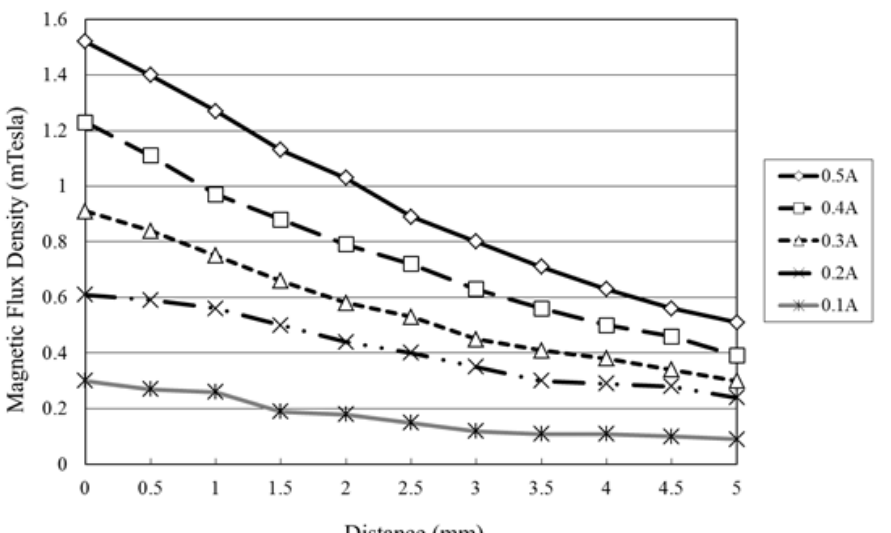
Figure 5. Variation of magnetic flux density produced by single-layer microcoil stack with vertical distance from microcoil surface given input currents of 0~0.5